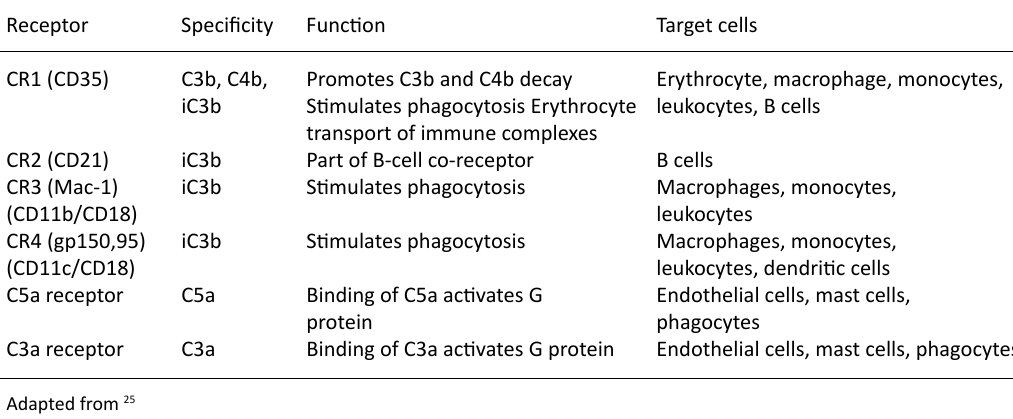
table 4. Types and functions of complement receptors Receptor